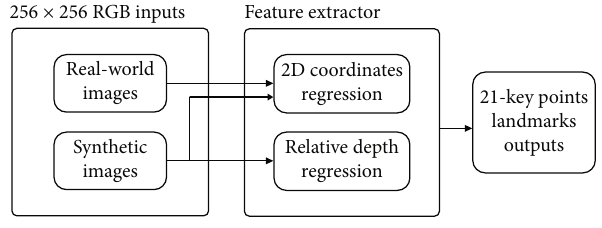
Figure 7: Structure of gesture landmark detector [9]. Table 1: Model performance on RWTH dataset.